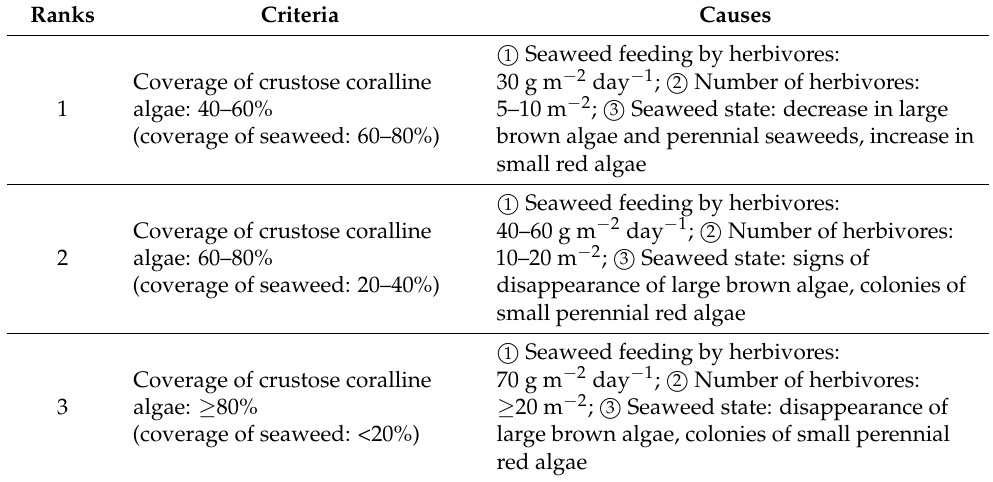
Table 5. Ranks, criteria, and causes of urchin barrens [362]. Of the causes, commercial resource utilization factors are